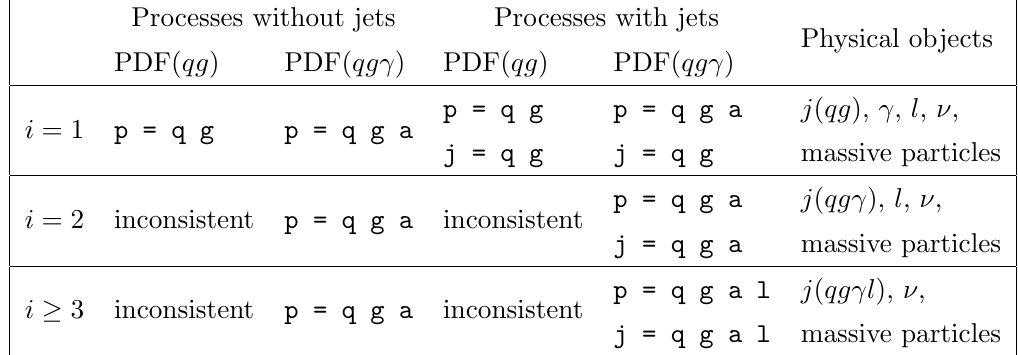
Table 4. Recommendations for the de(cid:12)nitions of the p and j multiparticles in the computations of the NLO corrections given in eq. (D.7). q stands for all of the massless quarks and anti-quarks of the loaded physics model, g is the gluon, a is the photon, and l collects all of the massless charged-leptons (for example, l = e+ e- mu+ mu- ta+ ta- ). In the rightmost column, by j , (cid:13) , l , and (cid:23) we denote jets, photons, charged leptons, and neutrinos, de(cid:12)ned as explained in the text; q and g denote light quarks and gluons,